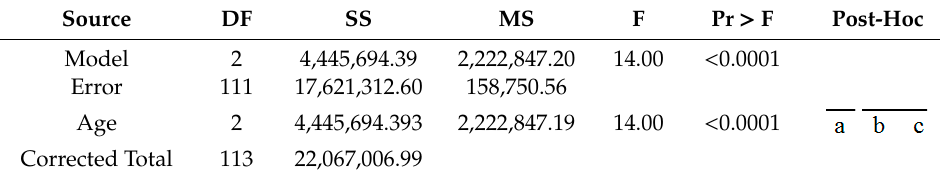
Table 8. Tukey post-hoc in male participants according to age.